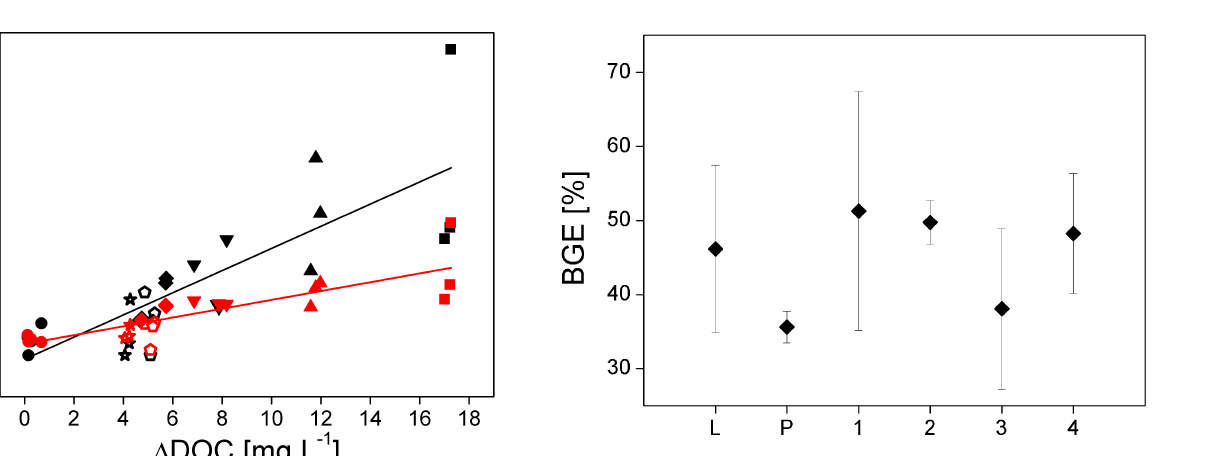
Fig. 5. Bacterial growth efficiencies (BGE) in single-source incu- bations with either DOC leaf (L) or DOC phyto (P) addition and in each treatment containing both DOC sources at the end ( t 12 ) of the experiment calculated from respiration and bacterial